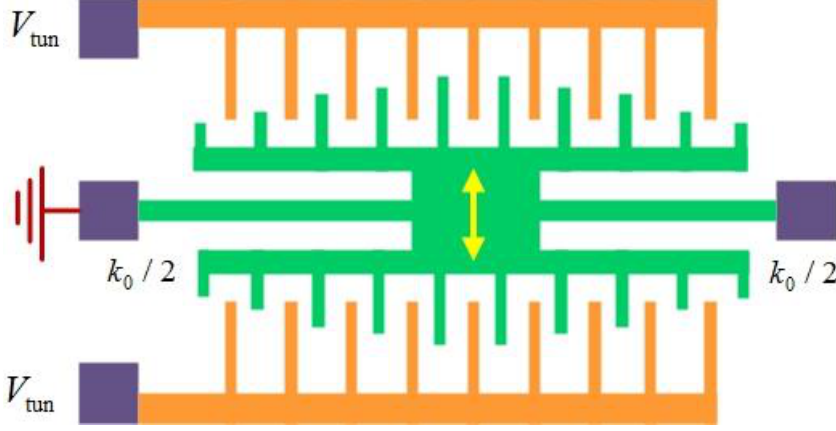
Figure 23. Resonant frequency tuning by capacitive softening